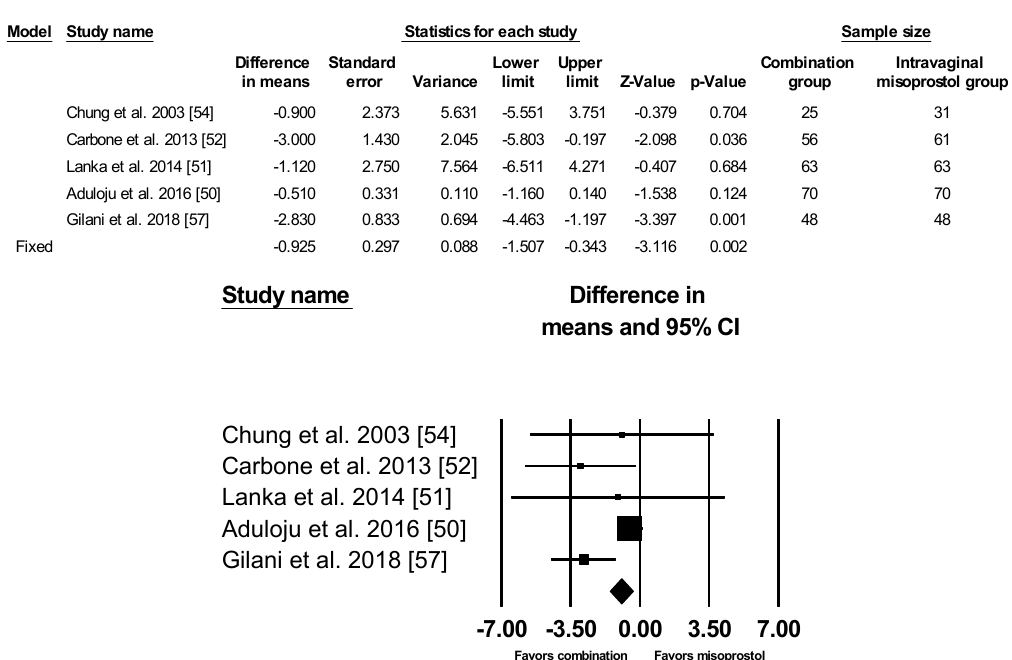
Figure 5. Comparison 4: Combination of intracervical Foley catheter and intravaginal misoprostol versus intravaginal misoprostol alone for cervical ripening, Outcome 4: Cesarean Section. Heterogeneity: Tau 2 = 0.006; ꭓ 2 = 7.631, df = 7 ( p = 0.366); I 2 = 8.266%. Test for overall effect (fixed): Z = − 0.723, ( p = 0.470). 3.3. Uterine Tachysystole with and without Fetal Heart Rate Changes